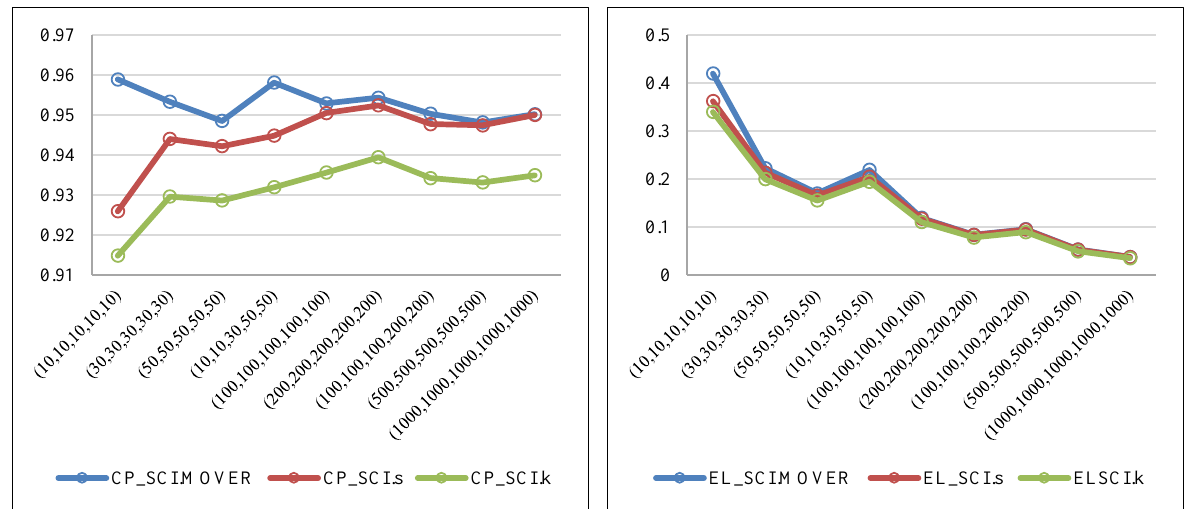
𝟏 ,𝒏 𝟐 , 𝒏 𝟑 , 𝒏 𝟒 , 𝒏 𝟓 )